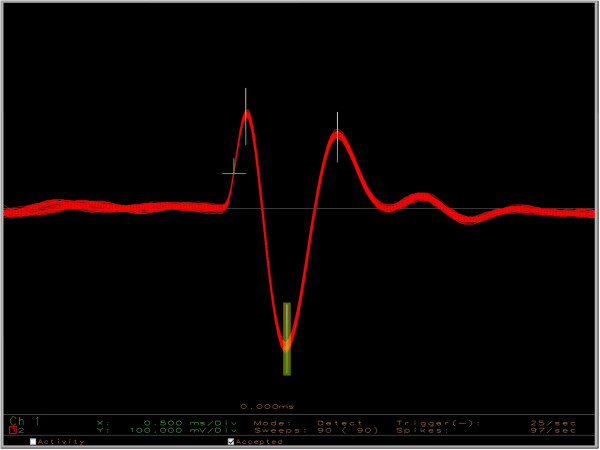
Neurophysiological recordings. An illustration of 90 (2-ms-long) action potential traces from a single unit displayed using custom-made spike sorting software (range of full screen: ±1 V). The signal to noise ratio is very high for these recordings.